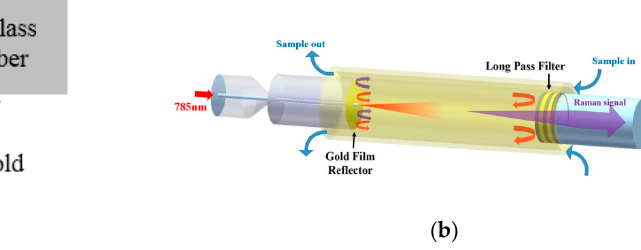
Figure 16. ( a ) Capillary with an inserted reflector structure diagram [10]. ( b ) Capillary with an inserted FP cavity detection experimental device structure diagram. Reprinted with permission from [46] © The Optical Society.